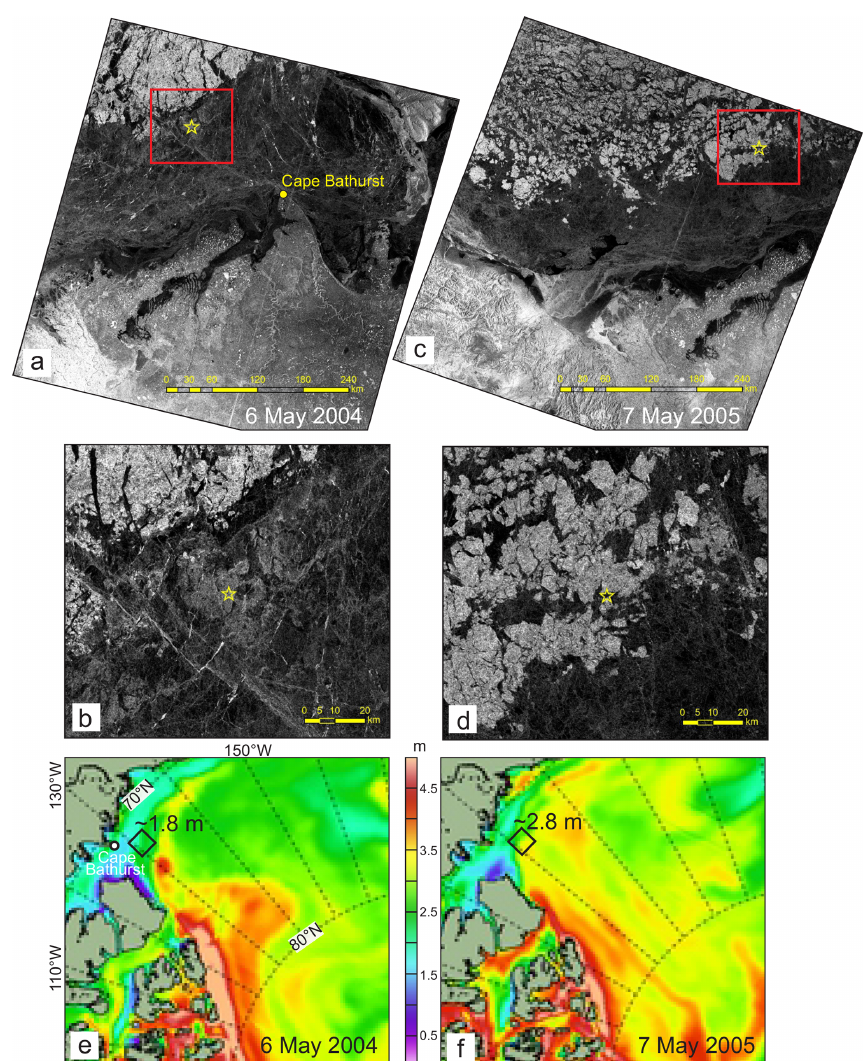
Figure 6. (a–d) RADARSAT satellite images taken before sea-ice breakup over the CA13 location northeast of Cape Bathurst on (a) 6 May 2004 and (c) 7 May 2005. Red rectangles show the mooring region enlarged in (b) and (d) . Yellow stars depict the mooring posi- tion. The dark areas are associated with the first-year pack ice ( < 2m thick). The lighter areas indicate the multiyear pack ice ( > 2m thick). (e–f) Spatial distribution of sea-ice thickness (m) based on the HYCOM + CICE model simulations for (e) 6 May 2004 and (f) 7 May 2005. The black diamonds depict the mooring position. Numbers show approximate sea-ice